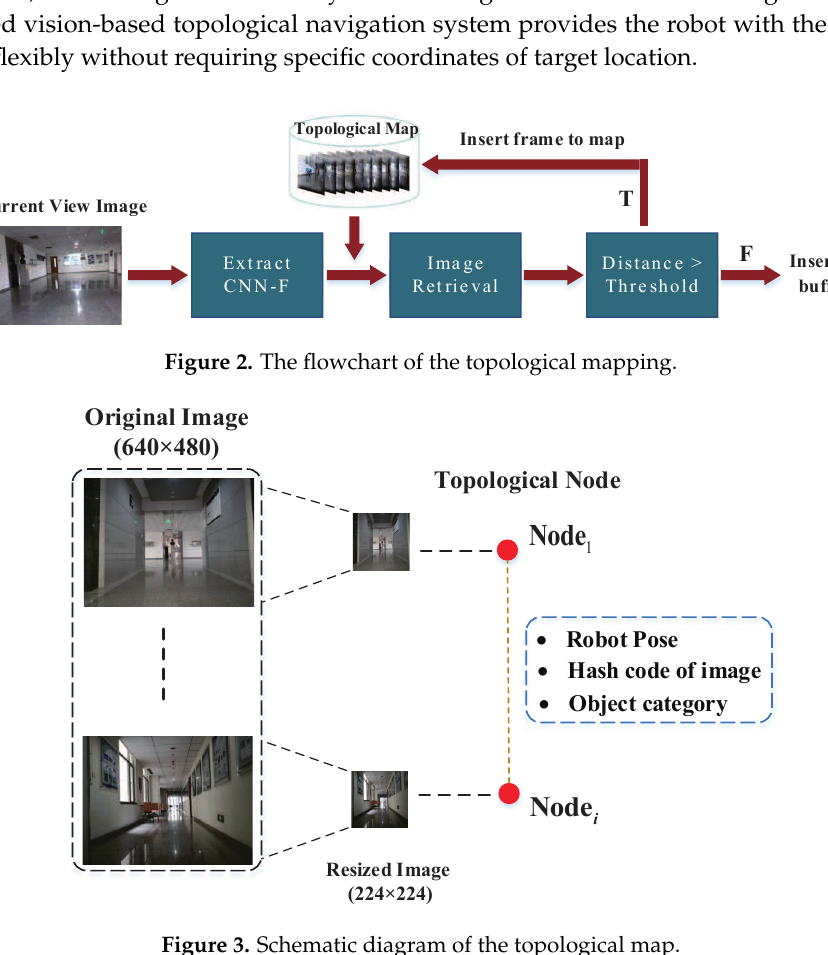
Figure 3. Schematic diagram of the topological